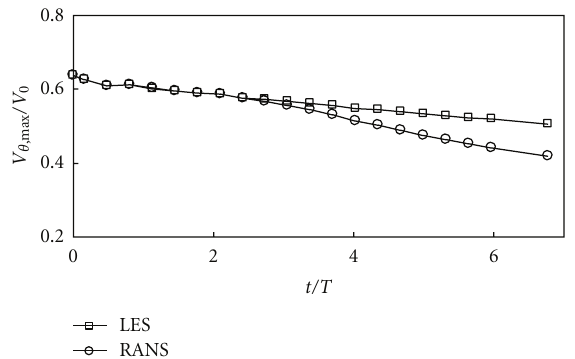
Figure 12: Time decay of maximum tangential velocity calculated by RANS and LES.